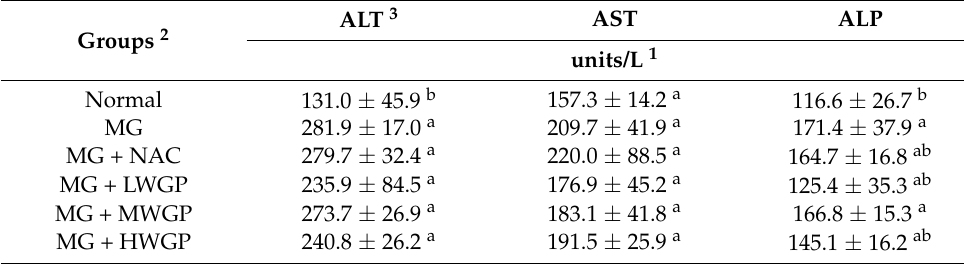
Table 1. Effects of WGP on bioactivities of serum ALT, AST, and ALP in MG-treated rats. Groups